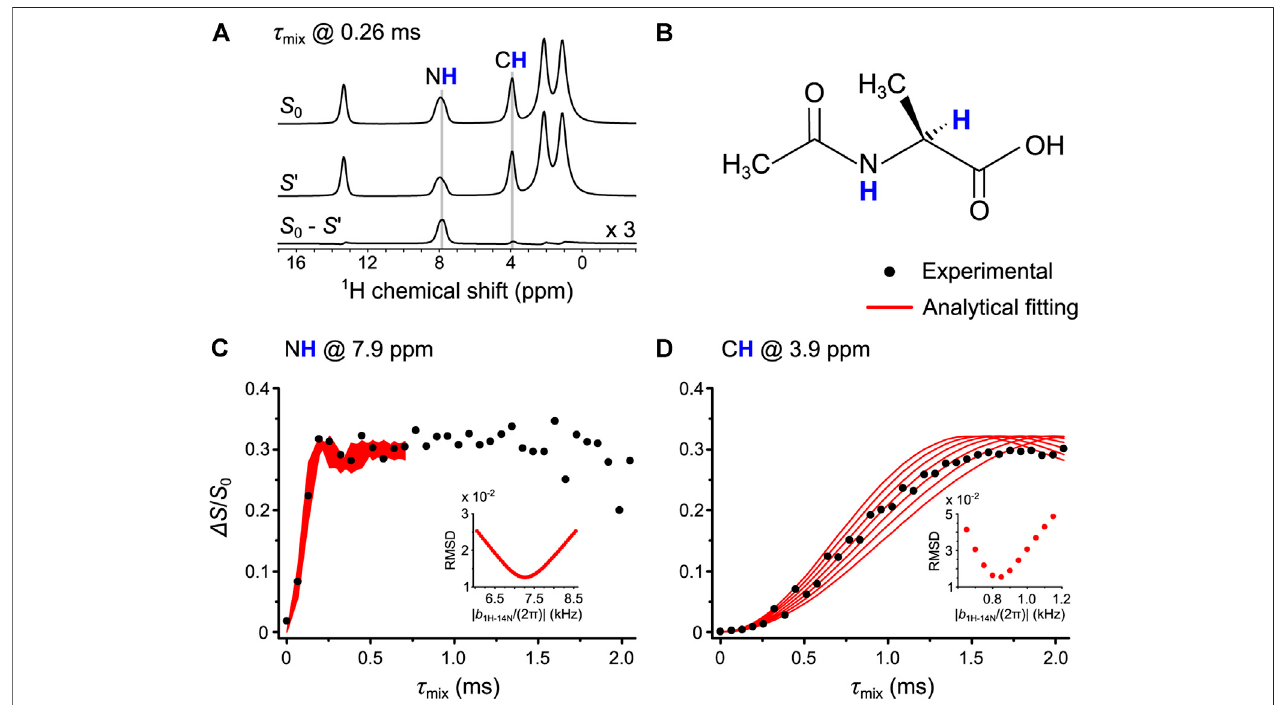
FIGURE 9 | (A) The 1D 1 H spin echo ( S ′ ), and the difference ( S – S ′ ) spectra of AcAla. These spectra result from the 1 H- 14 N OT-REDOR 0 ), the dephased ( S 0 experimentwith τ mix of0.26 ms.Forreadability,theintensityofthedifferencespectrumistriple. (B) ThemolecularstructureofAcAlawhereN H andC H arelocated.( C,D) The fi tting of experimental 1 H- 14 N OT-REDOR fraction curves (black circles) by the universal curves (red lines) for N H at 7.9 ppm in (C) and C H at 3.9 ppm in (D) . The fi tting parameter f for universal curves is 0.50. The RMSD analyses (inset) were calculated for the best fi tting 1 H- 14 N dipolar couplings.